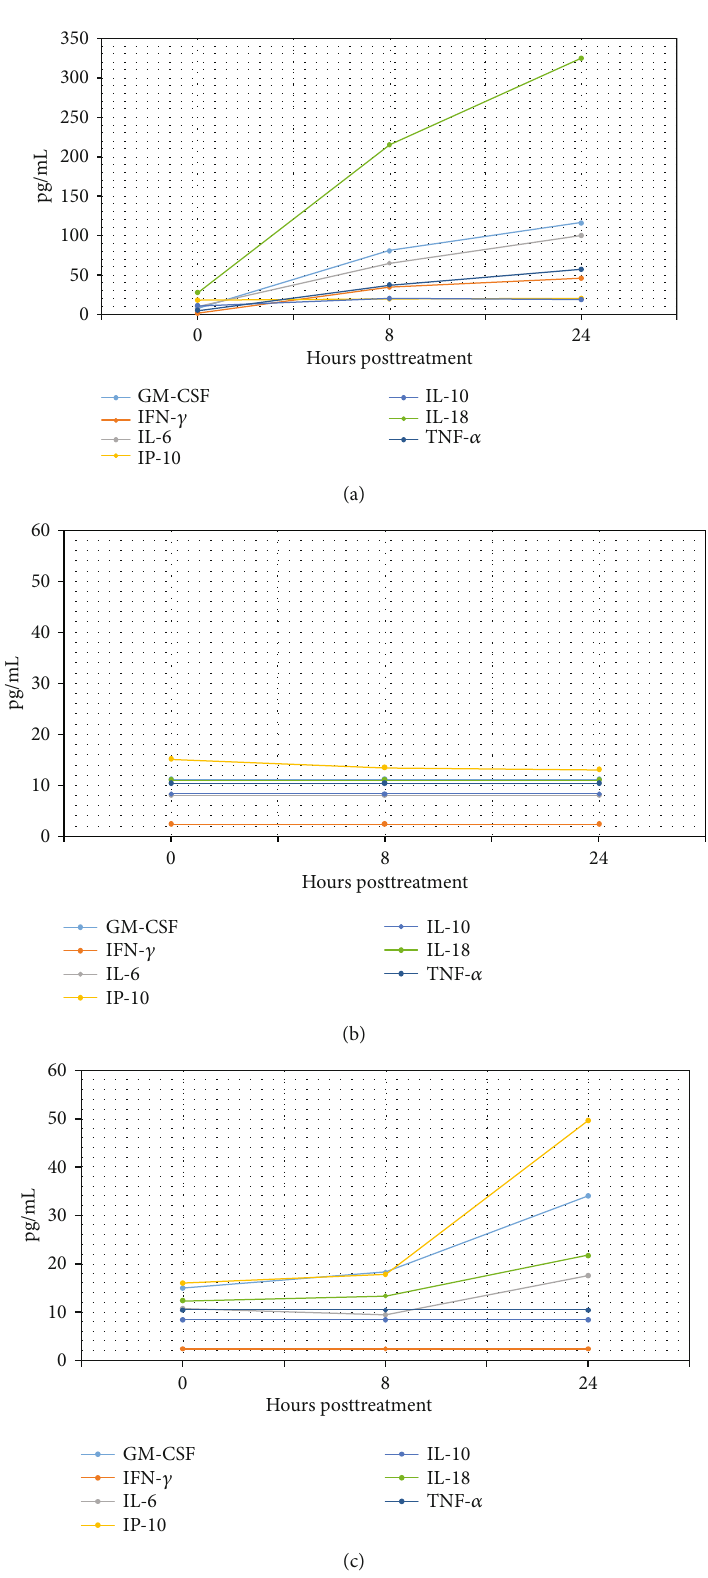
Figure 3: (a) Cytokine pro fi le in Subject One, (b) cytokine pro fi le in Subject Two, and (c) cytokine pro fi le in Subject